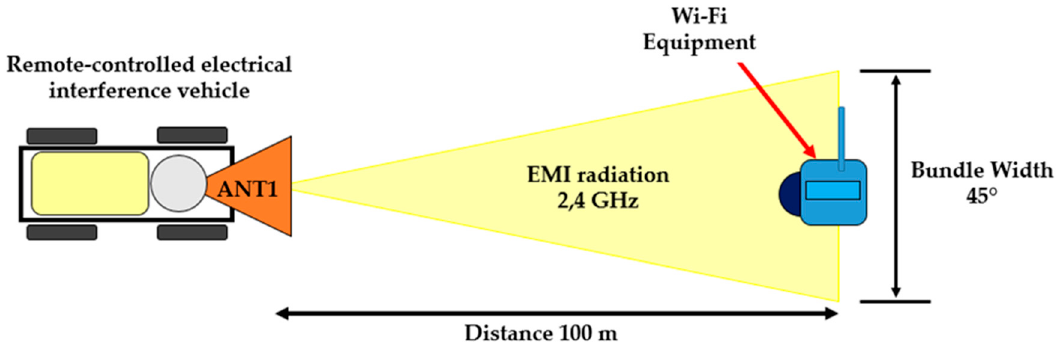
Figure 25. Interference using antenna 1 at a distance of 100 m.